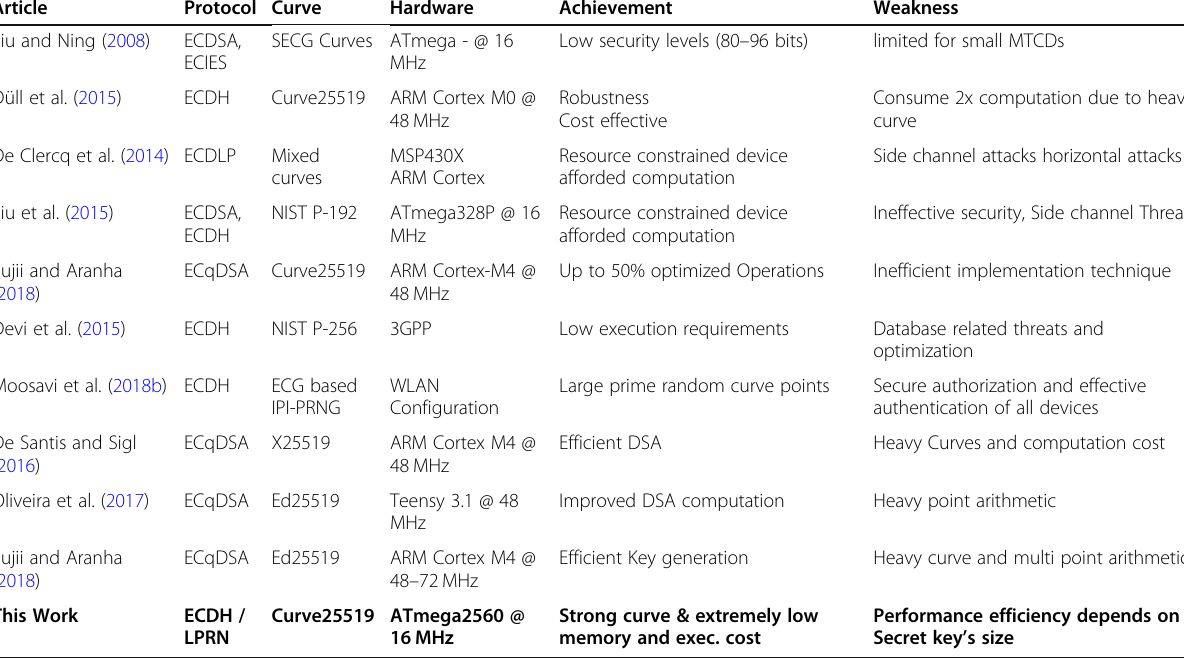
Table 8 Comparison with existing ECC techniques in resource constrained IoT